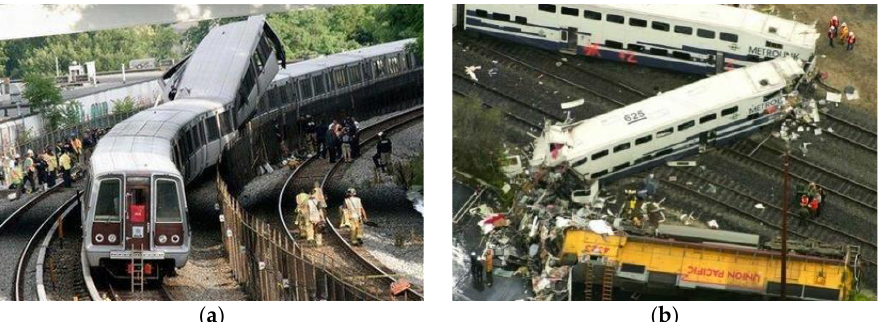
Figure 2. Climbing vehicles or zigzag derailment phenomenon. ( a ) A rear-end collision in the Wash- Figure 1. Overload protection bolts of the high-speed train couplings. Figure 1. Overload protection bolts of the high-speed train couplings. ington, D.C. Metro in 2009. ( b ) A derailment of a city passenger train in Los Angeles in 2008 (The Figure 1. Overload protection bolts of the high-speed train couplings. Railroad Accident Report of the United States National Transportation Safety Board).